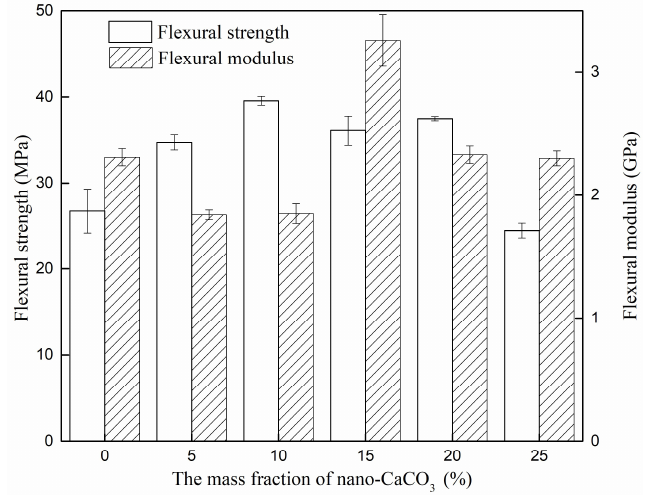
Figure 3. Flexural properties of core–shell structured WPCs.